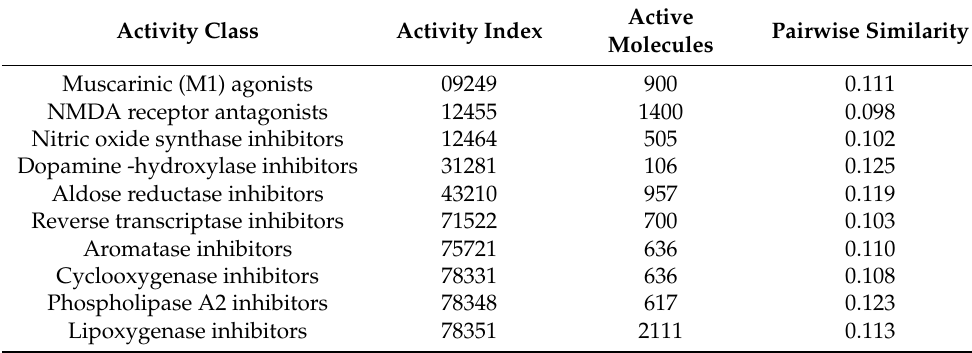
Table 3. The MDDR-DS3 (structurally heterogeneous) activity